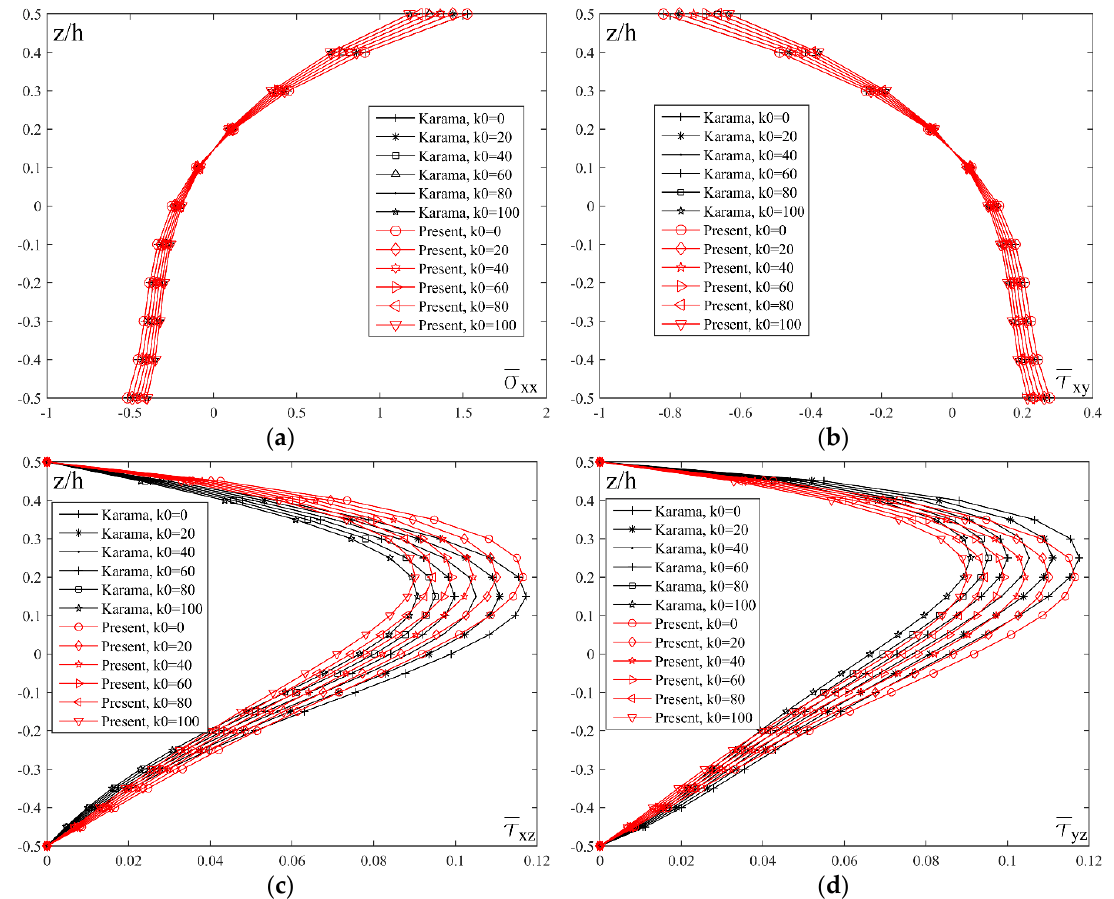
τ Figure 10. Distribution of the normalized values of the normal stresses σ xx , the shear stress τ xy and Figure 10. Distribution of the normalized values of the normal stresses σ , the shear stress and xy xx the transverse shear stresses τ xz and τ yz across the thickness of the plate on elastic foundation for τ the transverse shear stresses τ and across the thickness of the plate on elastic foundation for different values of the coefficients k 0 : ( a ) a / h = 10, a / b = 1, p = 2, k 1 = 10; ( b ) a / h = 10, a / b = 1, yz xz p = 2, k 1 = 10; ( c ) a / h = 10, a / b = 1, p = 2, k 1 = 10; ( d ) a / h = 10, a / b = 1, p = 2, k 1 = different values of the coefficients k 0 : ( a ) a/h = 10, a/b = 1, p = 2, k 1 = 10; ( b ) a/h = 10, a/b = 1, p = 2, k 1 = 10; ( c ) a/h = 10, a/b = 1, p = 2, k 1 = 10; ( d ) a/h = 10, a/b = 1, p = 2, k 1 = 10.